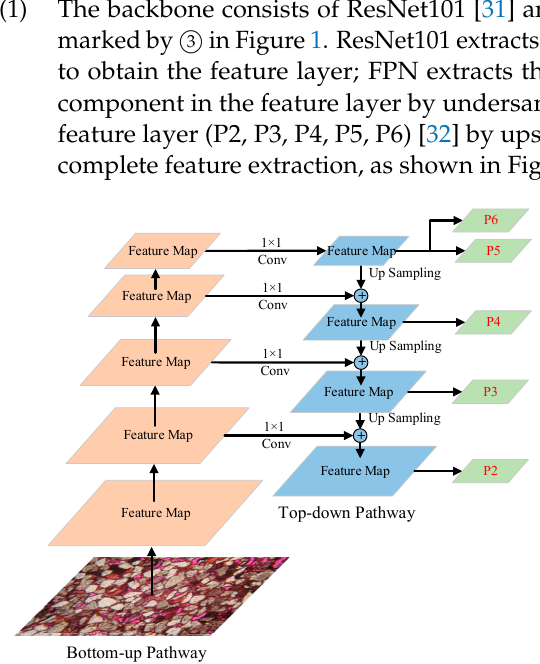
Figure 2. Feature pyramid network FPN.